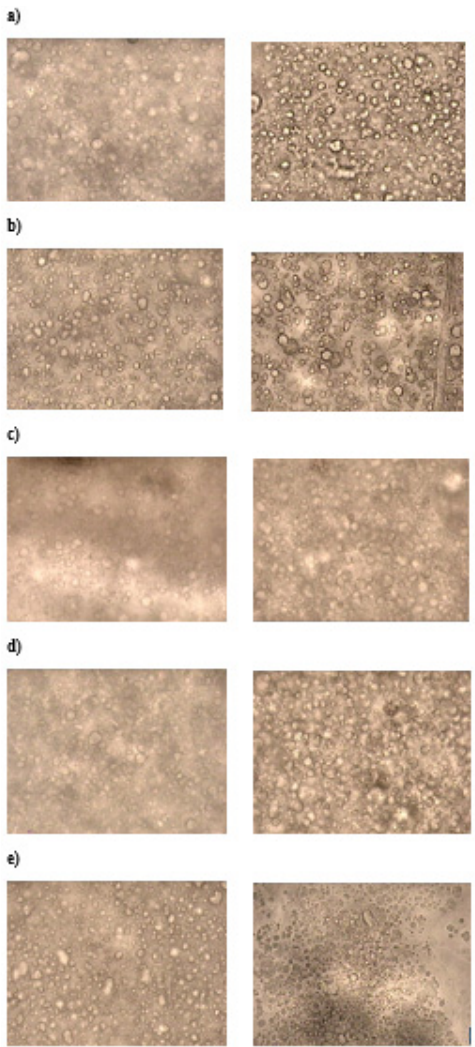
Figure 6. Micrographs obtained by optical microscopy, left = before thermal shock), right = after thermal shock (ATS). ( a ) Formula base, ( b ) P. edulis Sims fo edulis , ( c ) P. ligularis , ( d ) P. mollissima , thermal shock (ATS). ( a ) Formula base, ( b ) P. edulis Sims. fo edulis , ( c ) P. ligularis , ( d ) P. mollissima , ( e ) P. edulis (passion fruit, reference). ( e ) P. edulis (passion fruit,